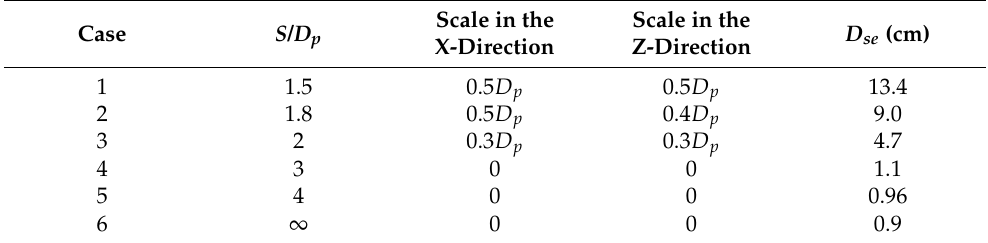
Table 4. Numerical simulation